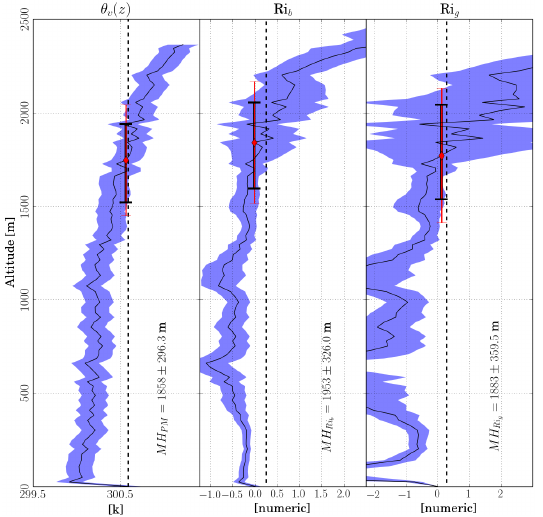
Figure 11. Potential temperature, Ri b and Ri g profiles at the Lin- denberg Meteorological Observatory on 20 June 2010, 18:00UT. The propagated errors are depicted as light blue areas around the profiles. On each plot, the localization error σ x error bar. Black bars represent the distinct contributions e 1 and e 2 to σ x . m